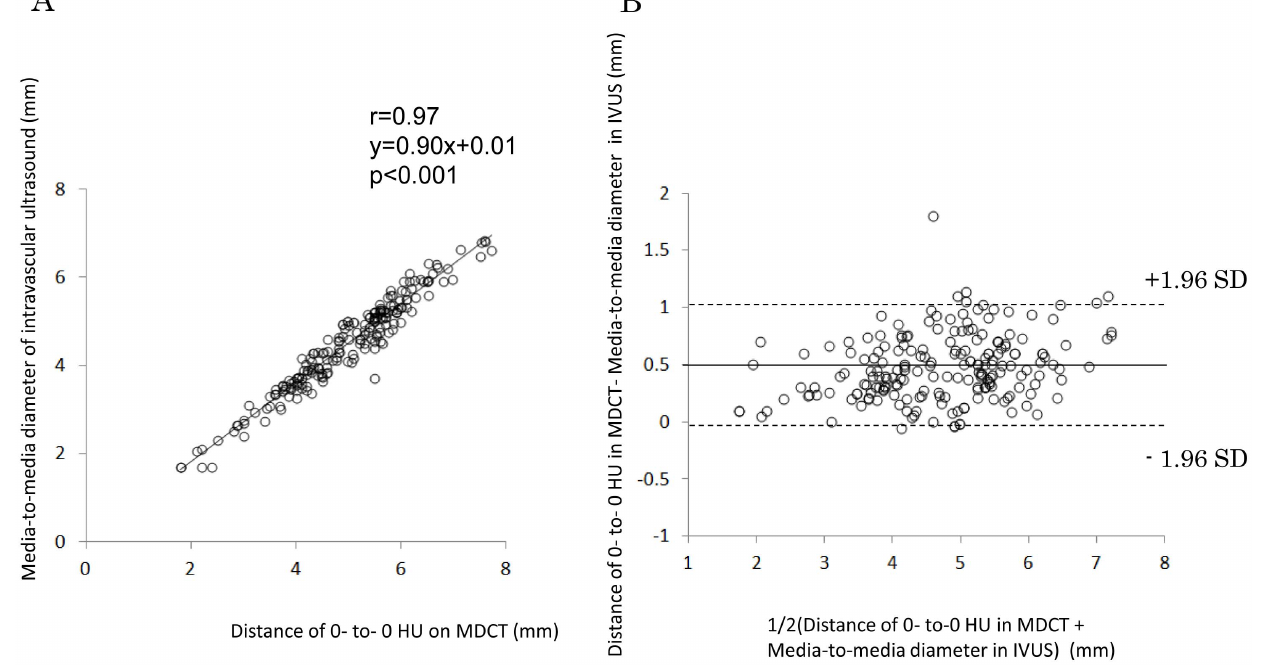
Figure 4. The correlation between 0-to-0 HU distance on MDCT (x) and media-to-media (IVUS) distance (y). doi:10.1371/journal.pone.0085312.g004 PLOS ONE |